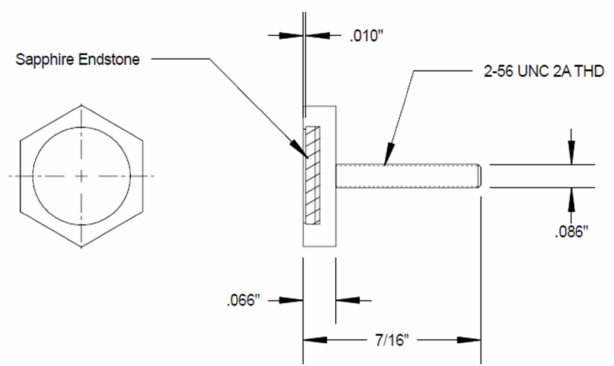
Figure 2. Endstone assembly.